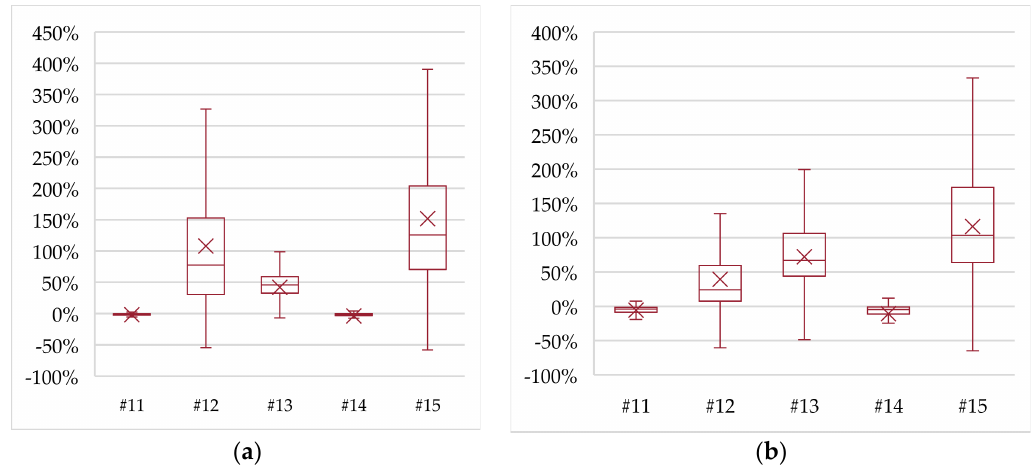
Figure 11. Resulted changes in ( a ) renewable energy use; ( b ) flexible loads.